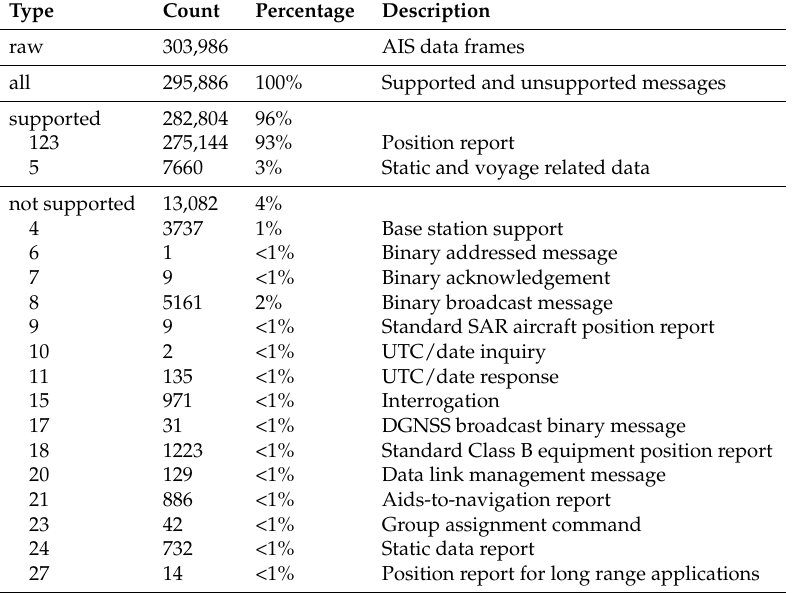
Table 7. Overview of AIS messages received on-board. For a detailed description, see [26].